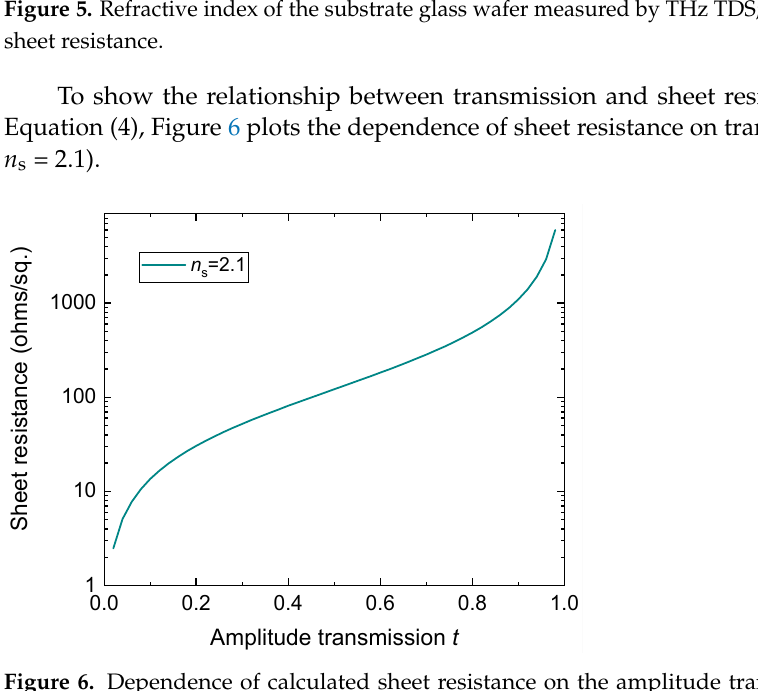
Figure 6. Dependence of calculated sheet resistance on the amplitude transmission t , assuming substrate refractive index of 2.1, as given by Equation substrate refractive index of 2.1, as given by Equation (4).